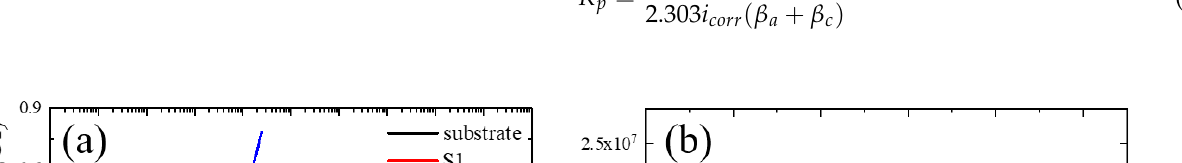
Table 2. Results of PDP tests of the bare substrate, S1, and S2 samples immersed in a 3.5 wt.% NaCl solution.